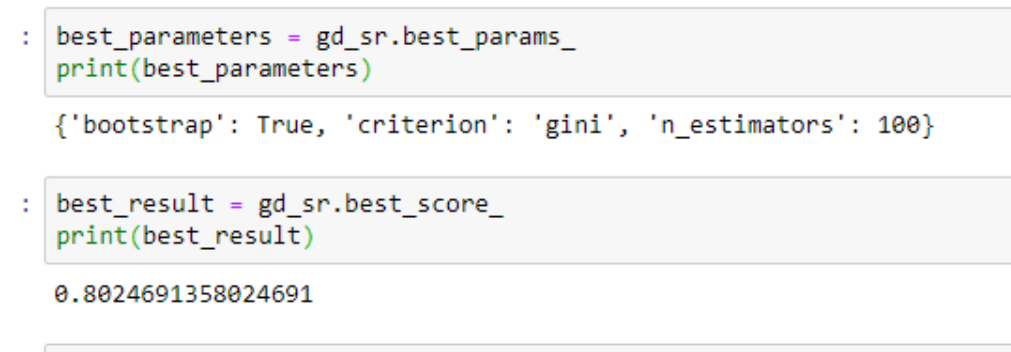
Figure 19. The accuracies achieved by the Folds after performing 10-Fold Cross-Validation on the RF model.